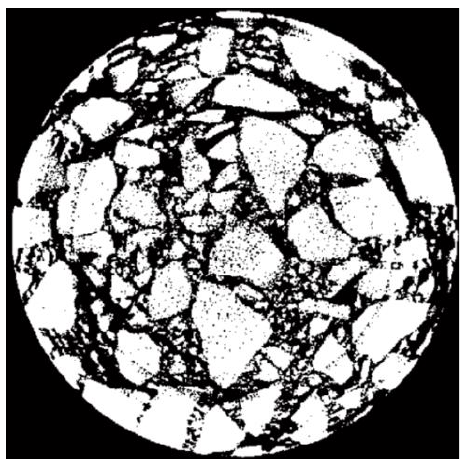
Figure 8. The effect after multiple annular separations.